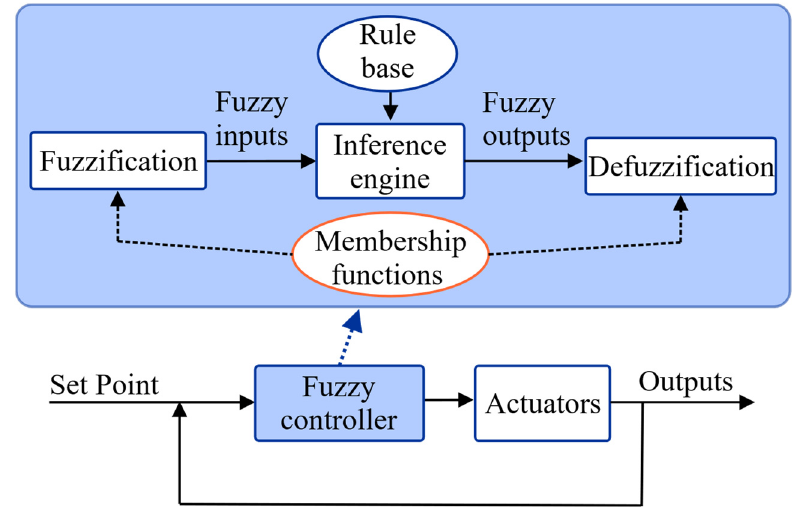
Figure 1. General scheme of a fuzzy controller.